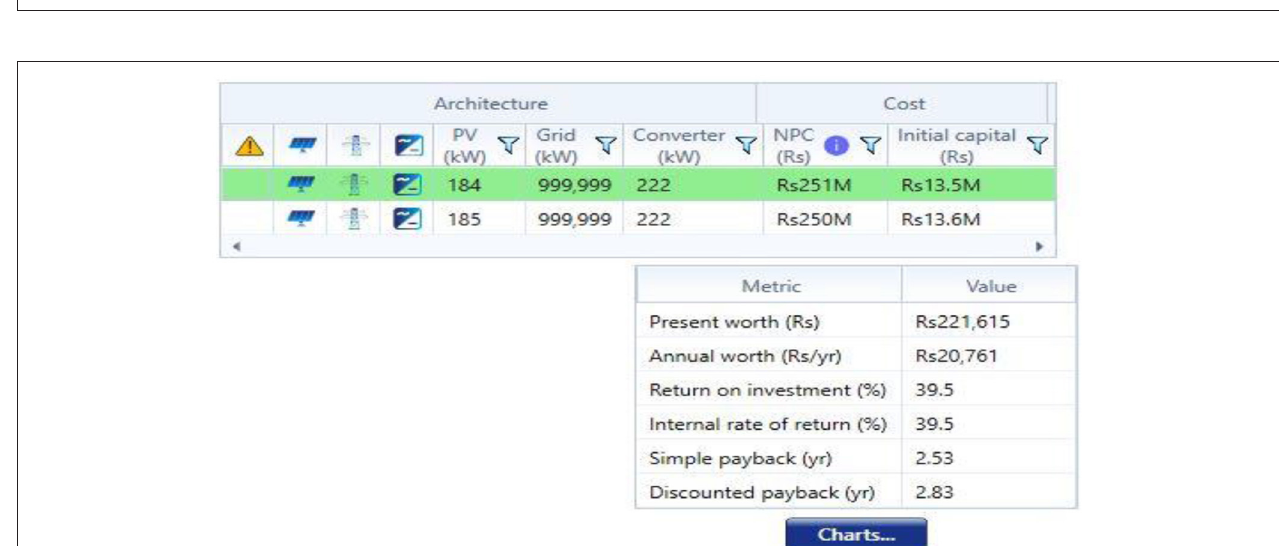
FIGURE 15 | Results of payback period in HOMER Pro